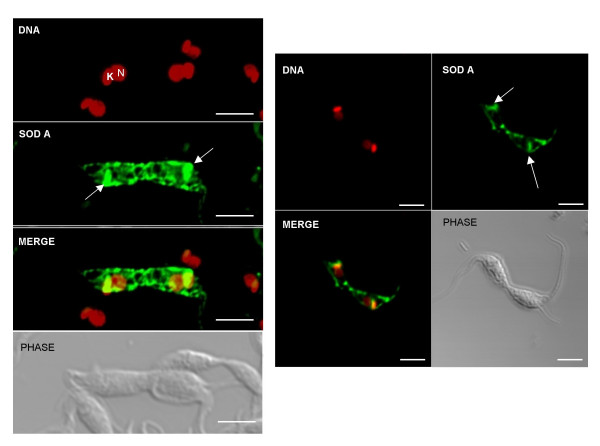
Immunofluorescence localisation of epitope tagged TcSOD A. Cells were induced as in Fig [8]. The parasites were fixed in paraformaldehyde and stained with mouse monoclonal anti-c-myc 9E10. Slides were examined on a Zeiss LSM 510 confocal microscope. The epitope tagged protein is shown as green fluorescence with the DNA stained red. Arrows indicate the strong staining of a structure adjacent to the kinetoplast (K). The nucleus is indicated (N). The white bar indicates 5 μm. The phase image is shown for comparison. Both images show cells in the process of dividing.